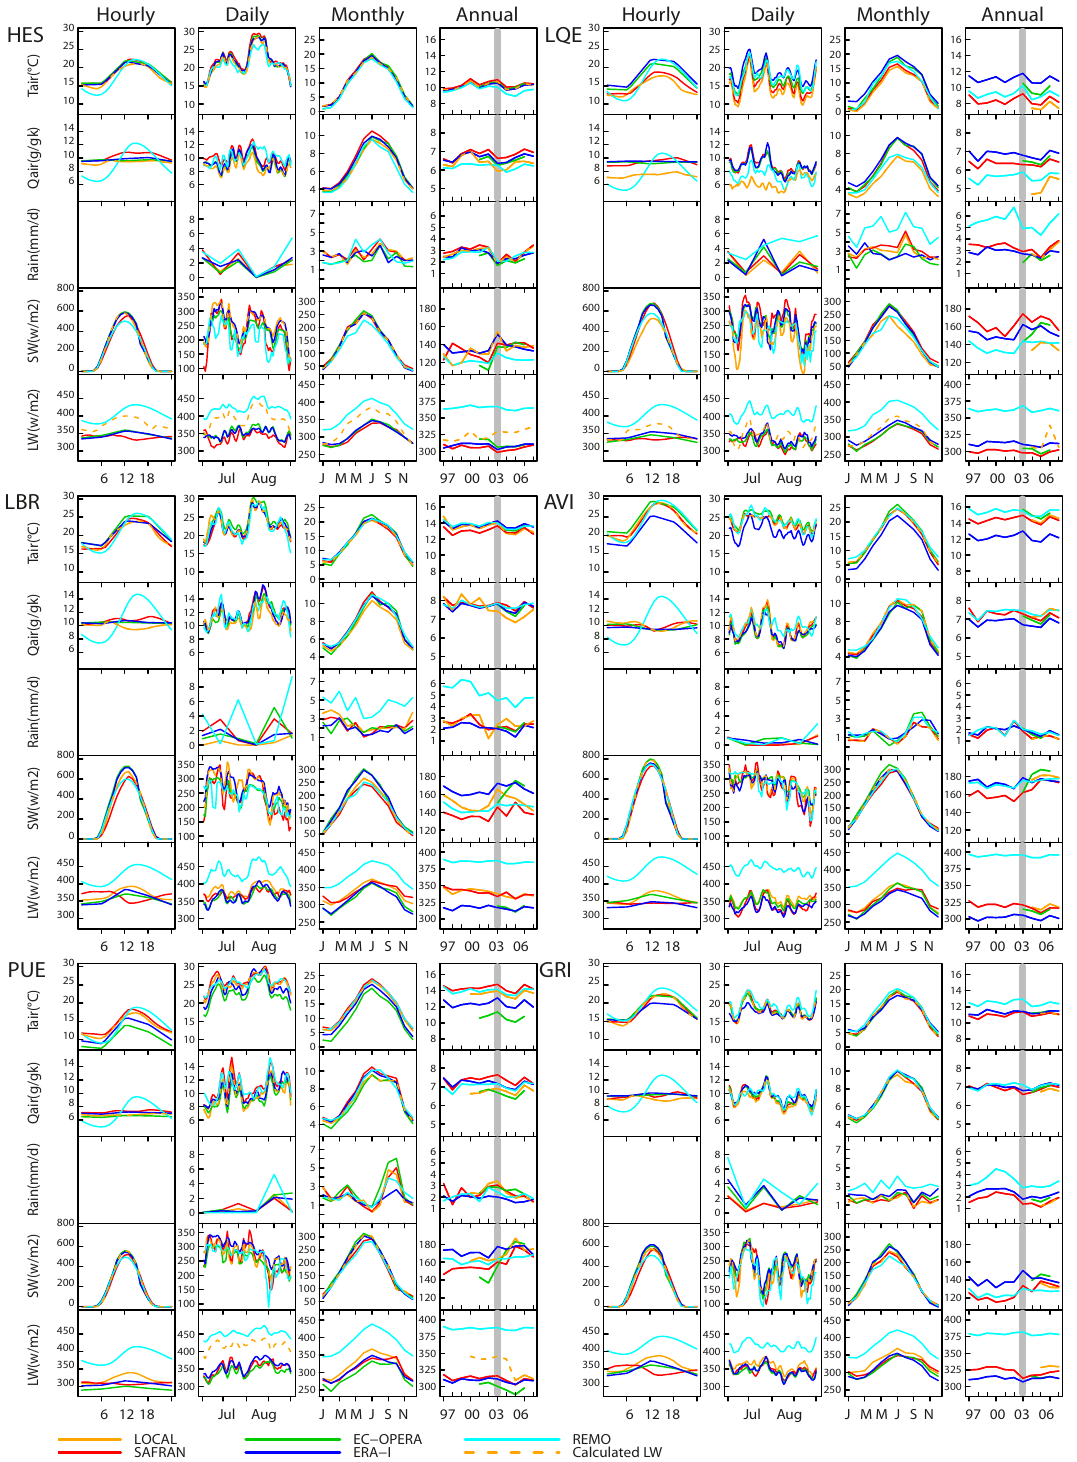
Fig. 2. Meteorological drivers in in situ and in gridded data sets at six sites. First column: hourly mean diurnal cycle over peak growing season (PGS). Second column: daily mean with a running mean of 3 days for July–August of 2003 at HES, LBR and PUE and of 2005 for LQE, AVI and GRI. Rainfall is calulated as 5-day aggregated values: third column: monthy mean seasonal cycle; fourth column: annual mean. The hourly mean diurnal cycle and monthly mean seasonal cycle correspond to 2004–2007 except for EC-OPERA (2003 to 2006). In the case of site-year without measured LW down , calculated LW down is plotted in dash lines. See text Sect. 2.1 for the definiton of